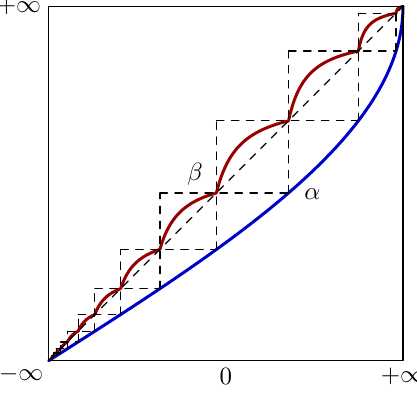
Figure 2: An example of Conradian action of BS ( 1 , 2 ) on the real